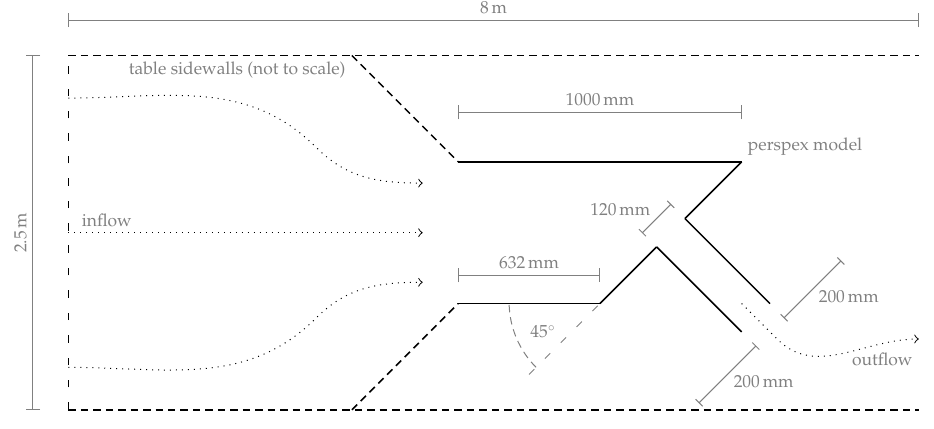
Figure 2. Experimental layout (not to